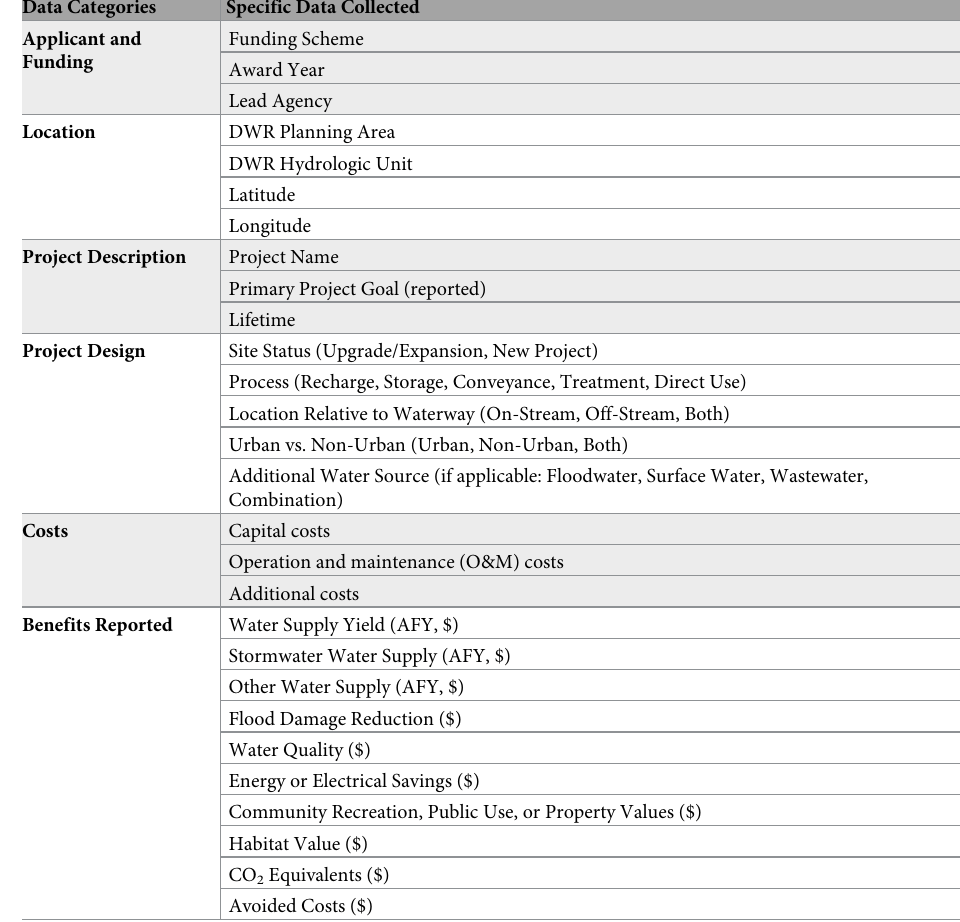
Table 1. Data collected from grant